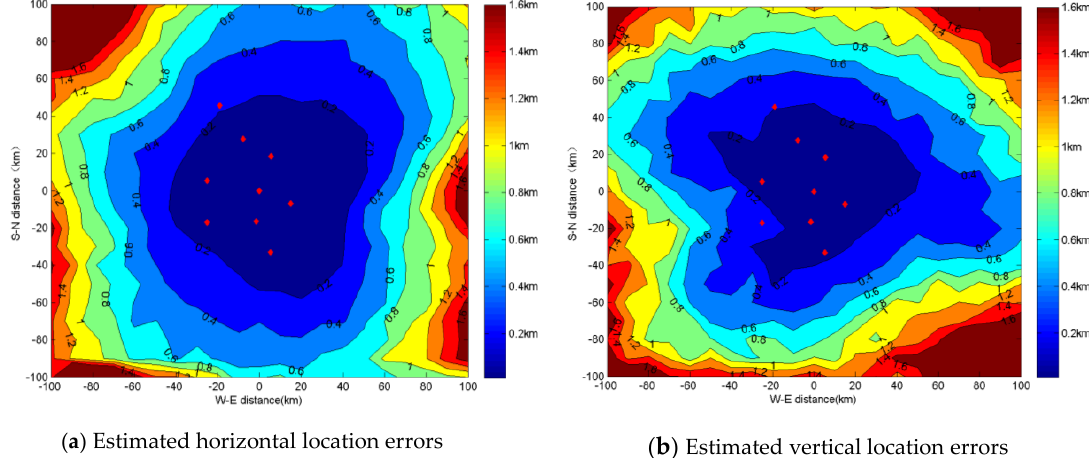
Figure 9. The estimated locating errors at an altitude of 10 km (( a ) horizontal error, ( b ) vertical error).